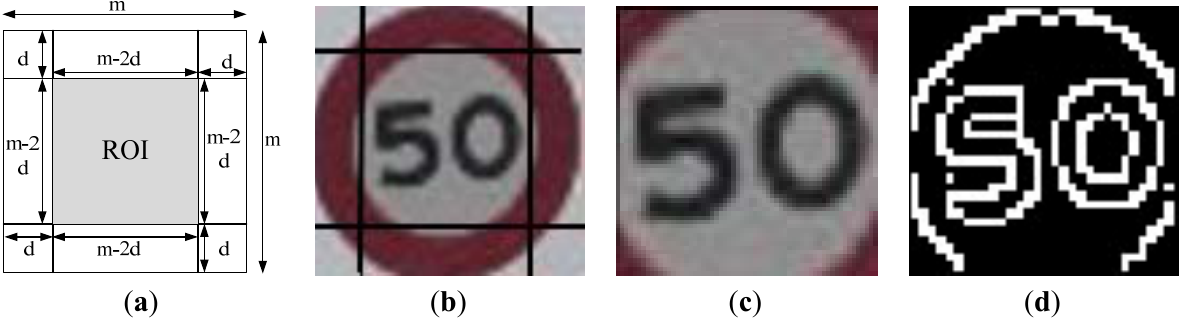
Figure 8. ( a ) The selected ROI for the extracted road sign candidate image; ( b ) its